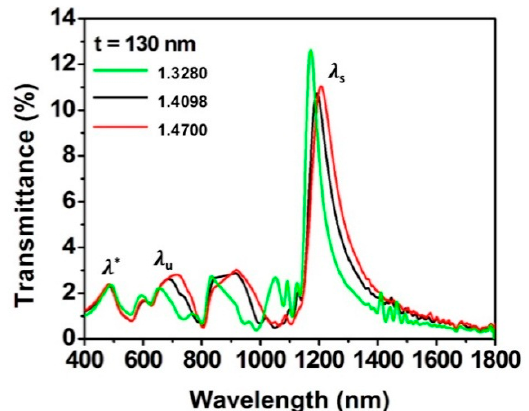
Figure 6. Transmission spectra of the sample with period of 675 nm, Au film thickness of 130 nm and hole diameters of 280 nm in different surrounding media.